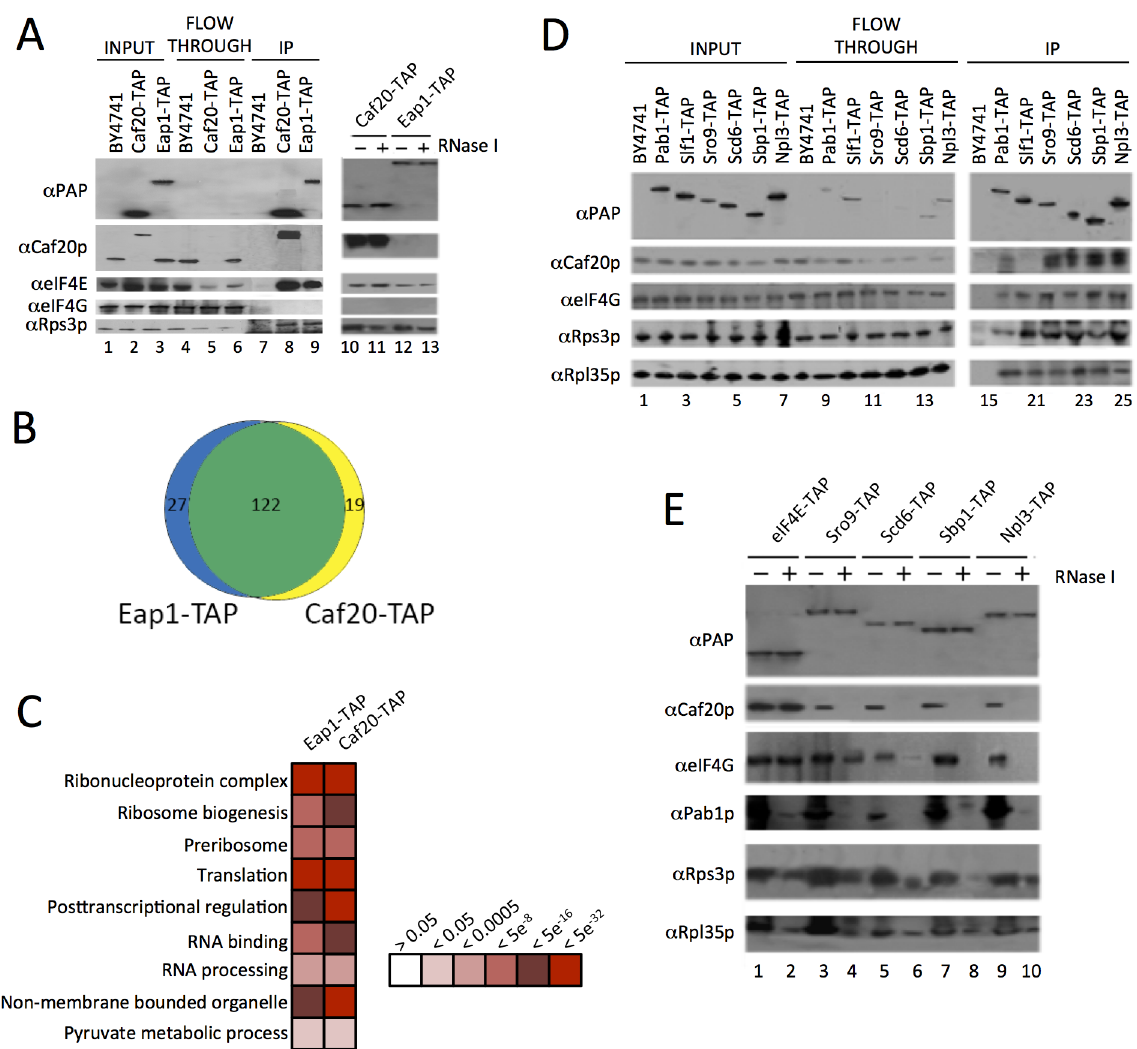
Fig 1. Identification of 4E-BP associating proteins using TAP-tag IPs. A. Western blots of the TAP IPs, lanes 1 – 9 show input, flowthrough and eluates for the IP strains and lanes 10 – 13 show the eluates of the 4E-BPs with and without RNase I digestion. Blots were probed with the α Protein A peroxidase (PAP) antibody (detects the TAP-tag), α Caf20p, α eIF4E, α eIF4G and α Rps3p to highlight IP efficiency and maintenance of previously published associations. B. Proportional Venn-style diagram depicting the overlaps between proteins associating with the 4E-BPs. C. Gene Ontology classes statistically overrepresented within 4E-BP associated proteins at indicated FDR significance. Only a representative selection of the significant functional categories is shown D. Western blots from reciprocal TAP IPs of a selection of RNA-binding proteins identified as interacting with the 4E-BPs probed with the indicated antibodies. E. Effect of RNase I digestion on protein interactions identified in